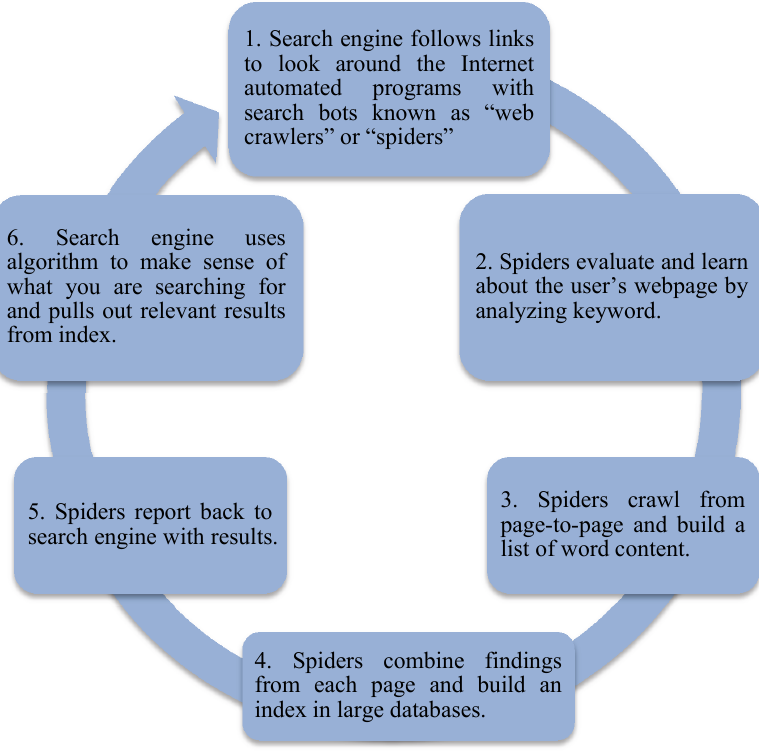
Fig. 1. How does Search Engine